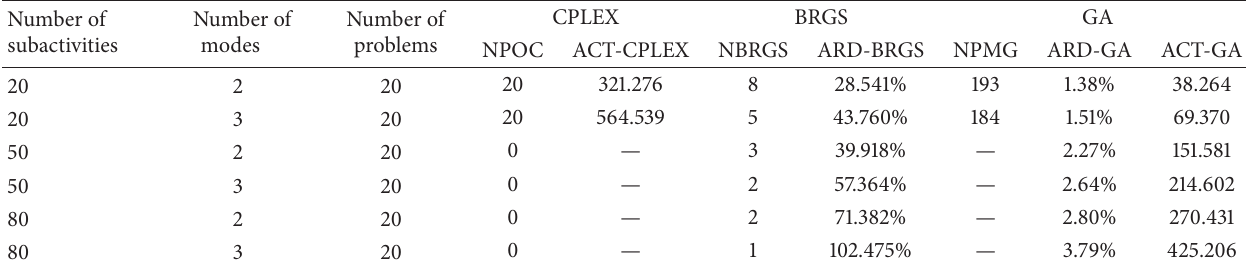
Table 3: Comparison of the results obtained by the CPLEX, GA, and